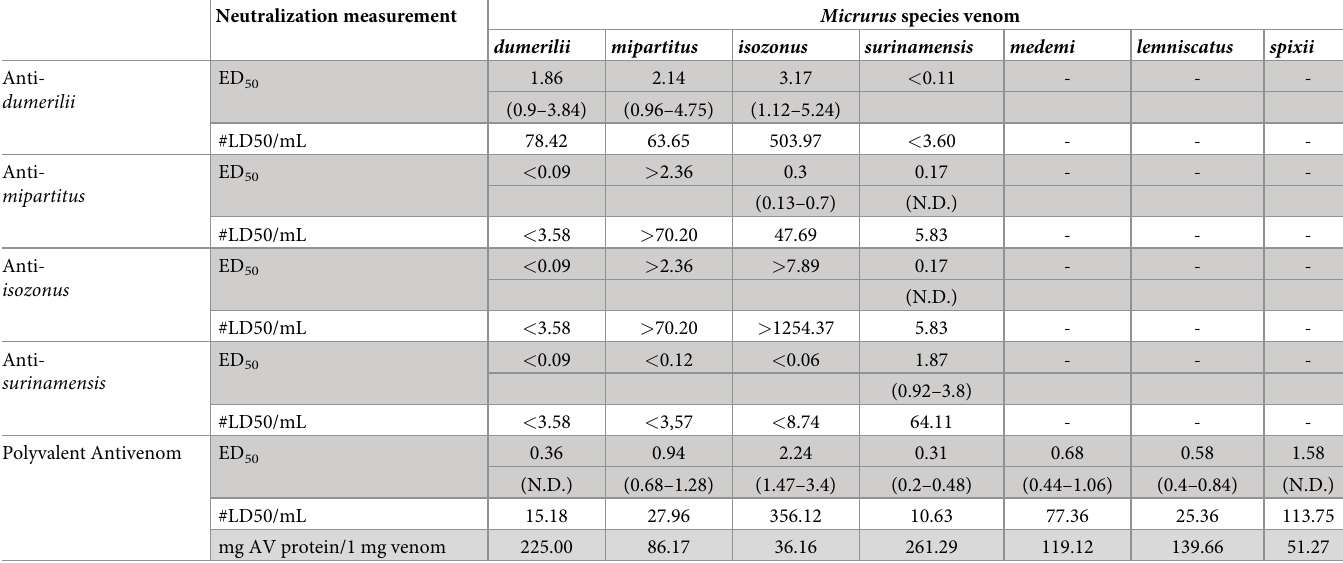
Table 2. Neutralization efficacy of monovalent and polyvalent antivenoms.